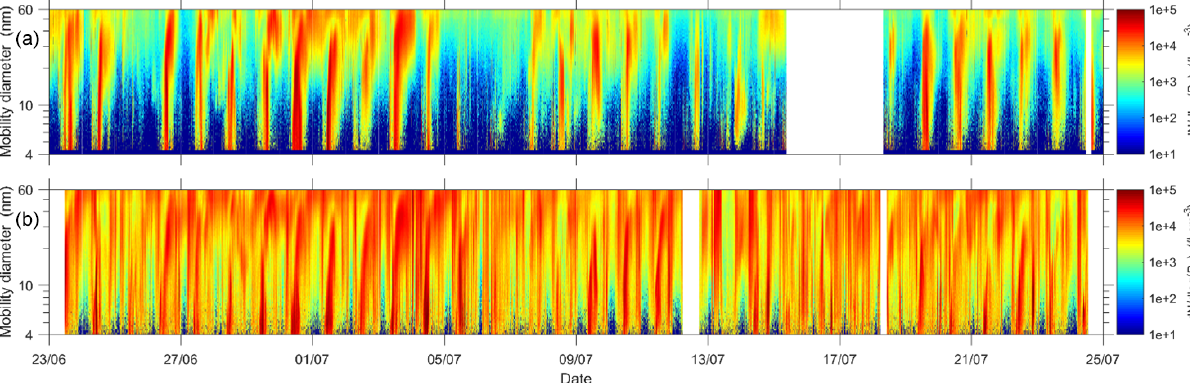
Figure 3. Size distribution time evolution from 23 June to 24 July at the SNS (a) and UGR (b)